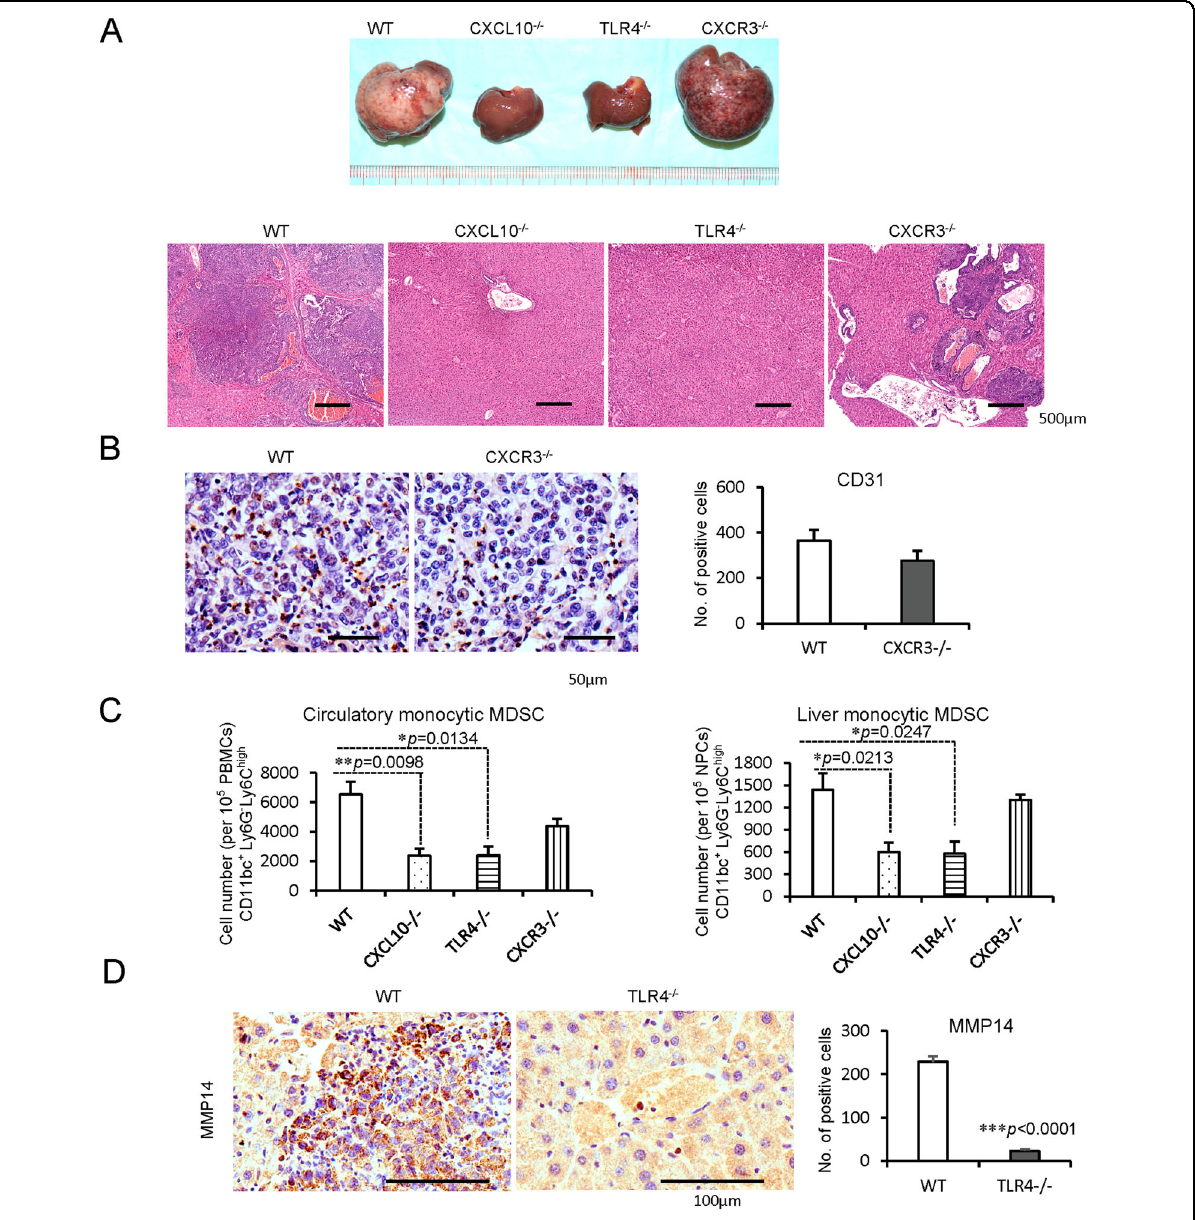
recurrence model. A Inhibited tumor development by knockout of CXCL10 or TLR4; scale bars: 500 μ m. B No signi fi cant change of in fi ltrated CD31 positive cells in tumor tissue between wild type and CXCR3 − / − mice; Scale bars: 50 μ m. C Less circulatory and hepatic monocytic MDSCs in CXCL10 − / − or TLR4 − / − mice. D Signi fi cant decrease of in fi ltrated MMP14 in TLR4 − / − mice in contrast with wild-type ones; scale bars: 100 μ m. N = 5/group; error bars indicate standard error of mean; *p < 0.05, ** p < 0.01, *** p < 0.001. MDSC myeloid-derived suppressor cell, MMP14 matrix metallopeptidase 14, IRH ischemia/reperfusion plus major hepatectomy, WT wild